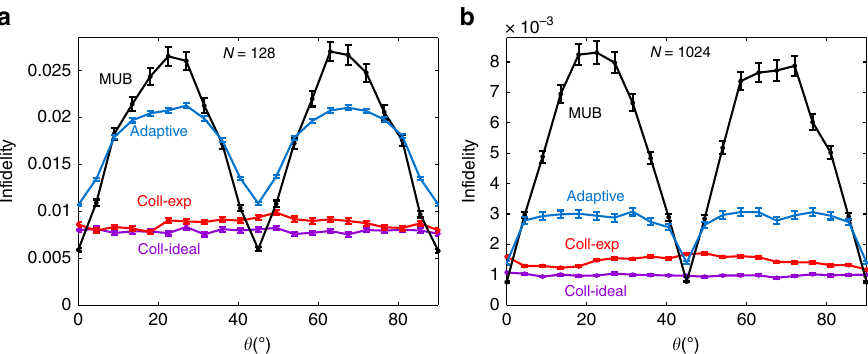
Fig. 5 Mean in fi delities achieved by the collective SIC-POVM in estimating a family of pure states. These pure states have the form ψ ð θ Þj i = sin θ 0 j i þ cos θ 1 j i . The performances of MUB and two-step adaptive measurements (simulation) are shown for comparison. The sample size is N = 128 in a and N = 1024 in b . Each data point is the average of 1000 repetitions, and the error bar denotes the standard deviation